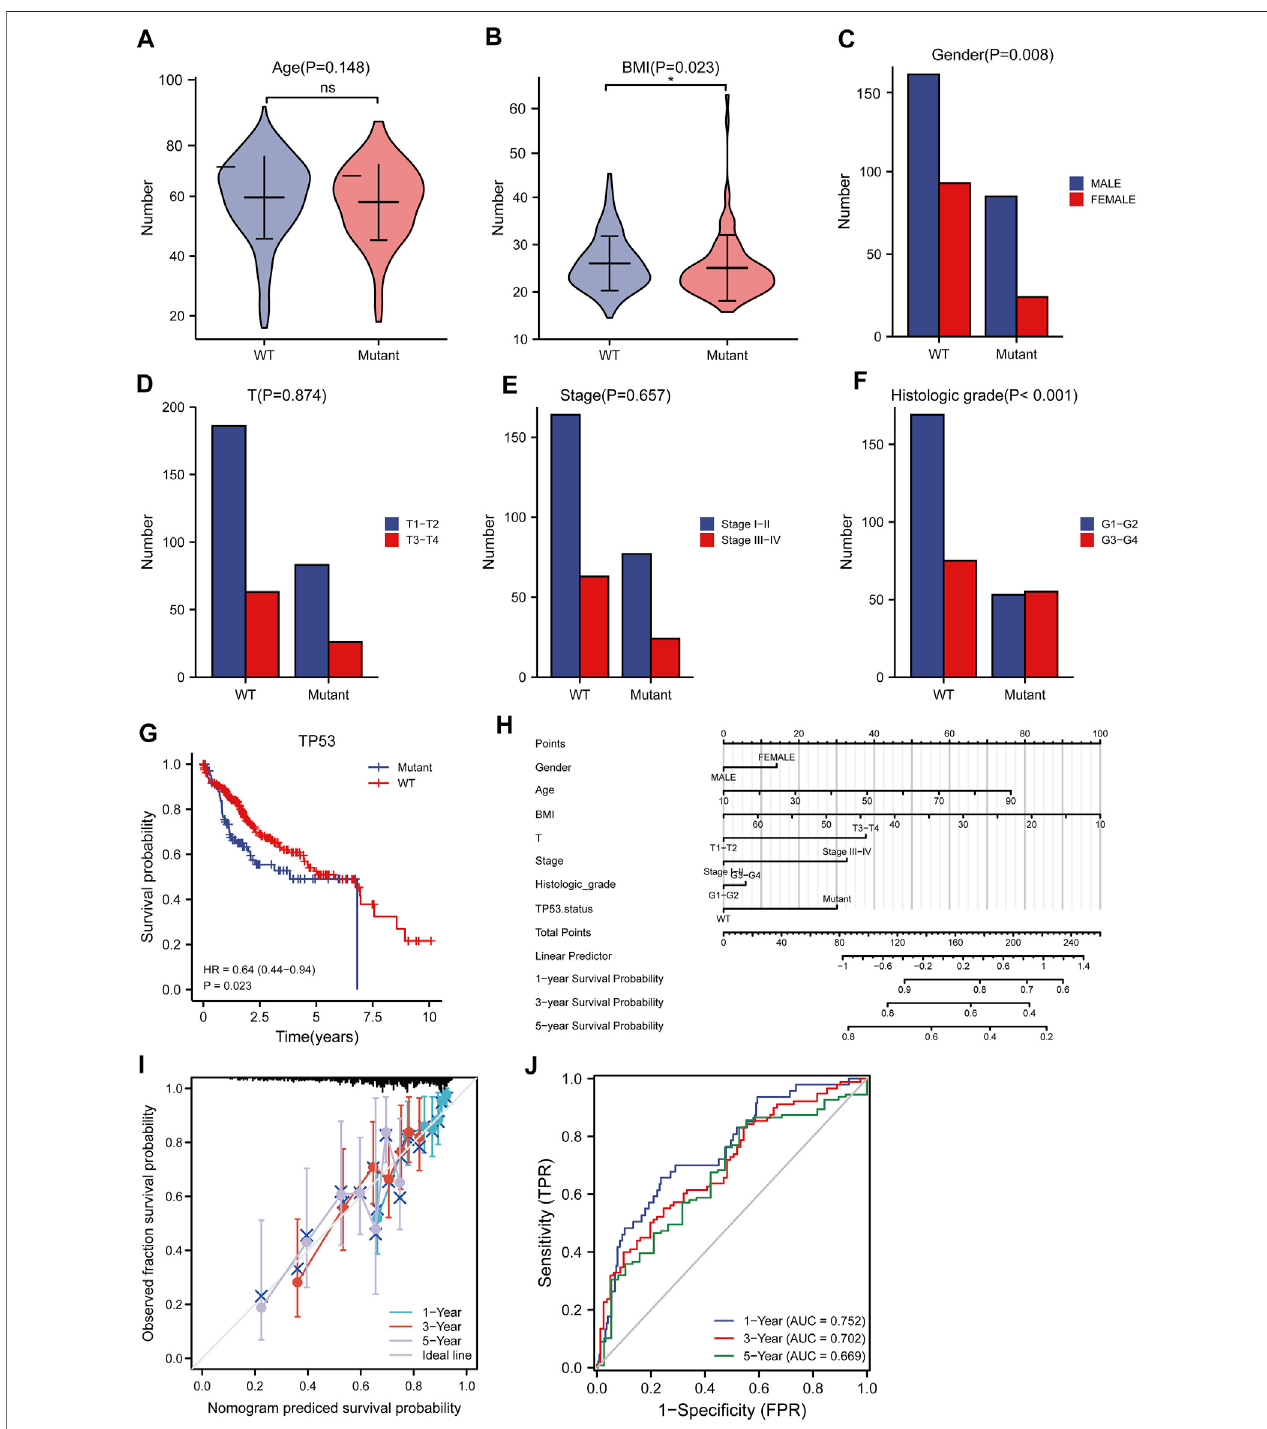
FIGURE9| AnalysisofclinicalcorrelationofTP53mutationandconstructionofprognosticmodel. (A) :Therewasnosigni fi cantdifferenceinagebetweentheTP53 mutationgroupandthenon-mutationgroup( p =0.148). (B) :TheBMIoftheTP53mutationgroupwassigni fi cantlylow( p =0.023). (C) :Thereisasigni fi cantdifferencein gender ( p = 0.008). (D,E) : No signi fi cant difference in clinical T staging ( p > 0.05). (F) : There are signi fi cant differences in pathological grading ( p < 0.001). (G) : Survival analysis showed that OS with TP53 mutation was signi fi cantly shortened ( p = 0.023). (H) : nomogram. (I) : Calibration curve. (J) : Time-dependent ROC curve.